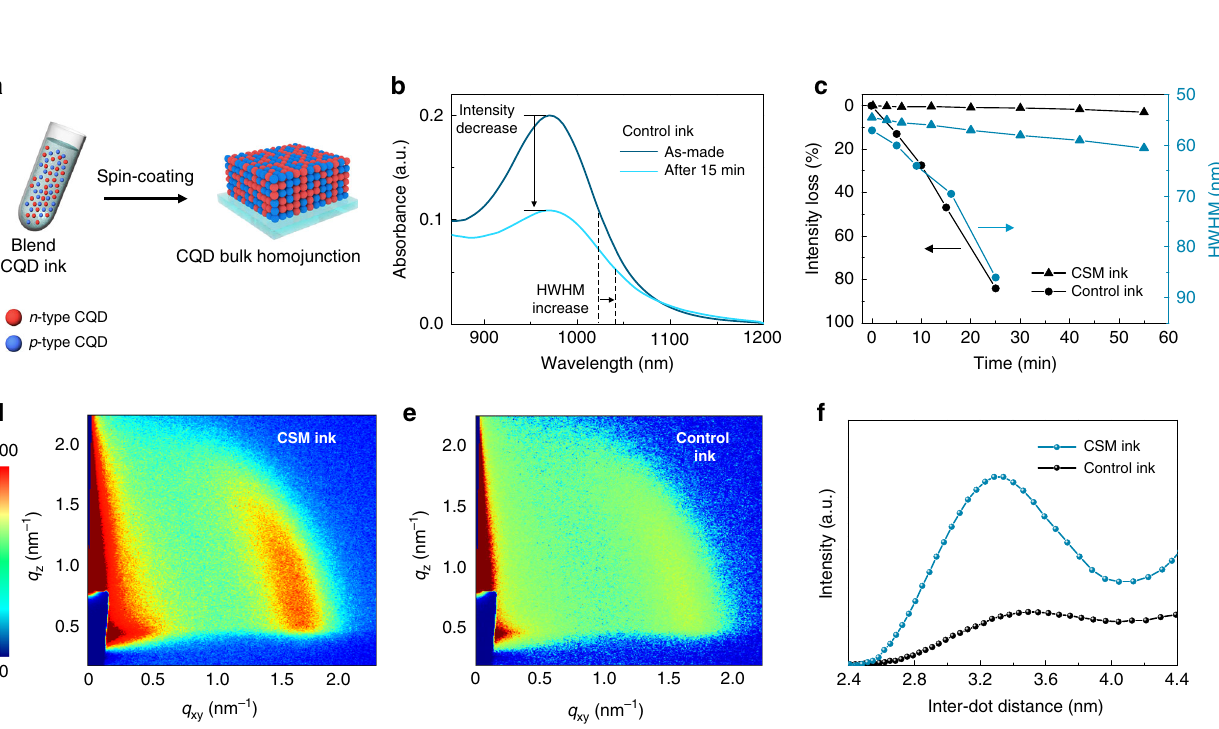
Fig. 2 The fabrication of a blend of CQDs to form bulk homojunction fi lms. a Blended CQD inks comprising n -type and p -type CQDs for the fabrication of CQD bulk homojunction fi lms. b The absorption spectra of a blend CQD inks (control) in the case of as made and also 15 min later. The absorption spectrum changes rapidly due to the precipitation and heterogeneous fusion of CQDs. c The intensity loss and an increase of HWHM in the absorption spectra as a function of time for control vs. CSM-blend CQD inks. d – e GISAXS two-dimensional pattern of CQD bulk homojunction fi lms made by CSM inks ( d ), and control inks ( e ). Blue color represents lower intensity and red color represents higher intensity. f Azimuthally integrated GISAXS intensities reveal more uniform and dense packing of CQDs in the fi lm with CSM